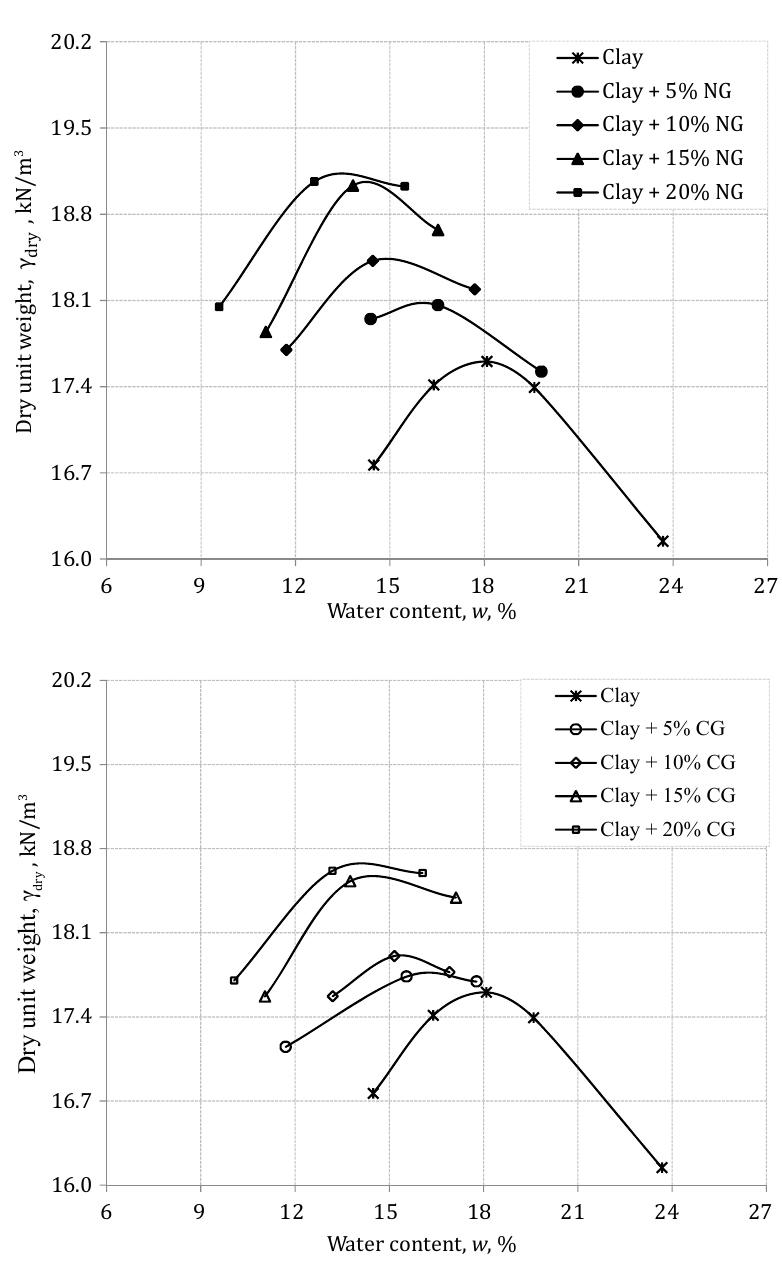
Figure 3. Compaction curves for clay with NG (top) and CG